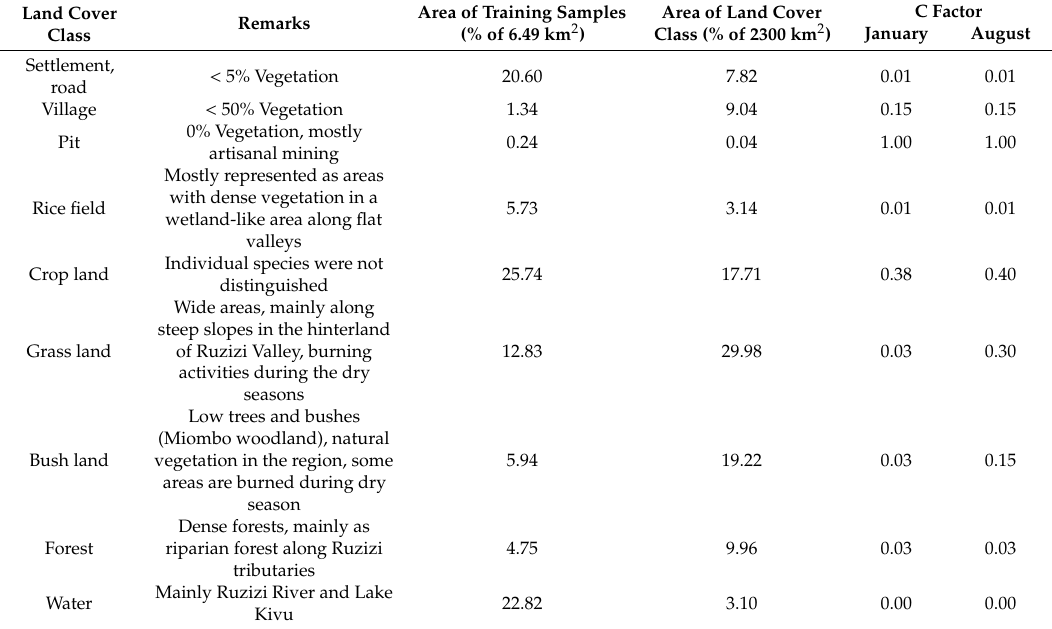
Table 3. Classes of Maximum Likelihood Classification and respective C factors, mainly based on the Malaysian Department of Agriculture (2010 [23:41], see Table 2).